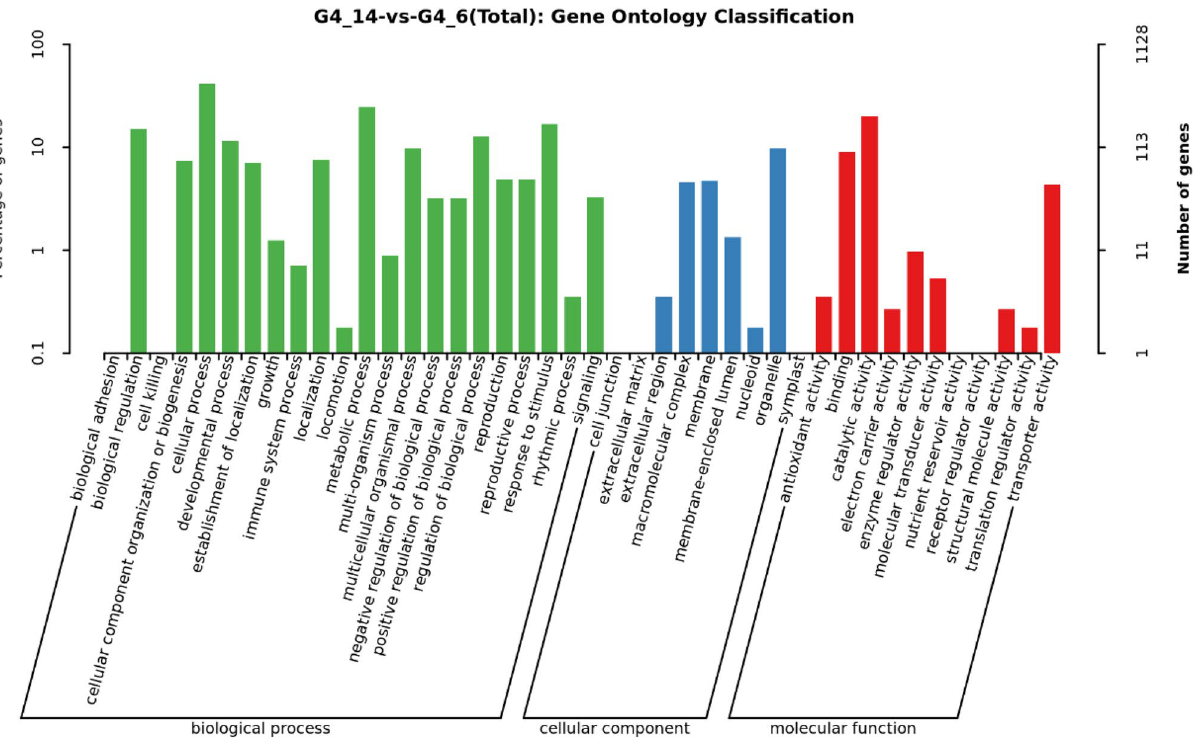
Figure 4. Gene Ontology (GO) enrichment analysis of different samples: The abscissa is the GO classification, the left side of the ordinate is the percentage of genes, and the right side is the gene